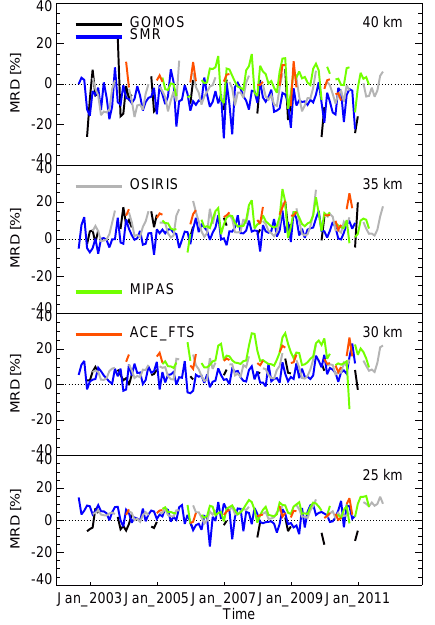
Figure 1. Mean relative difference (cid:49) ( z ) time series between all in- struments (comparison sensor) and SCIAMACHY (reference sen- sor) in the latitude band 70–60 ◦ N.